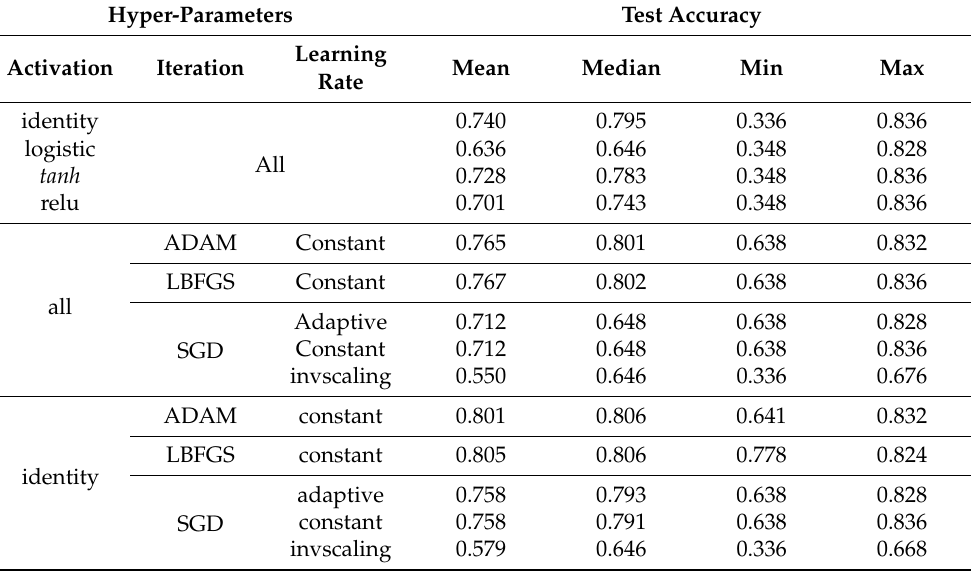
Figure 8. Cross-validation accuracy of the MLP-ANN classifier. ( a ) 100 neurons, 1 hidden layer, ( b ) 200 neurons, 1 hidden layer, ( c ) 100 neurons, 6 hidden layers ( d ) 200 neurons, 6 hidden layers, ( e ) 100 neurons, 3 hidden layers. Table 4. Test accuracy of the MLP-ANN classifier (5-fold and 10-fold).